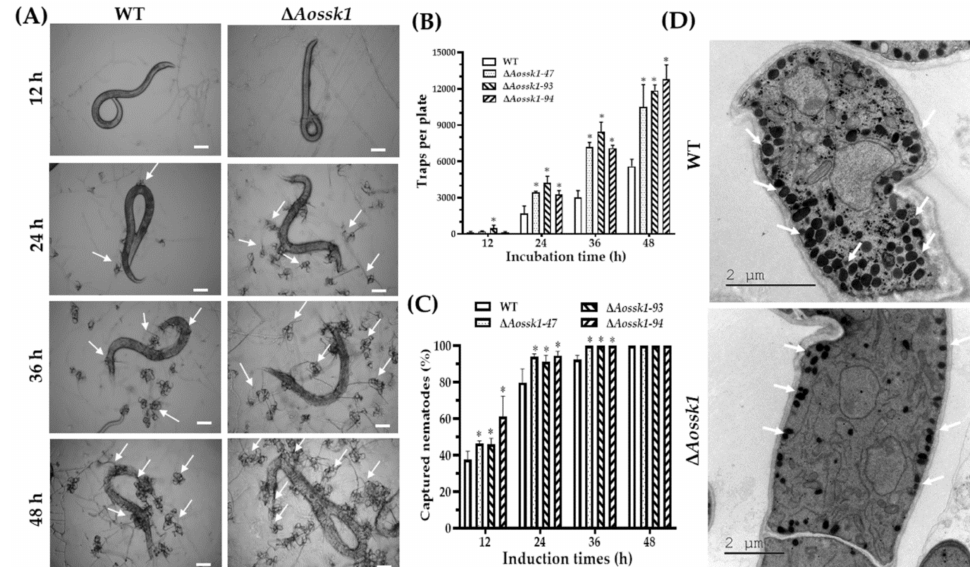
Figure 6. Comparison of trap formation, nematicidal activity, and electron-dense bodies between WT and ∆ Aossk1 mutant strains. ( A ) Trap formation and nematode predation at different time points. White arrows: traps. Bar = 50 µ m. ( B ) Comparison of traps produced by WT and ∆ Aossk1 mutant strains at 12, 24, 36, and 48 h. ( C ) Comparison of nematodes captured by WT and ∆ Aossk1 mutant strains at 12, 24, 36, and 48 h. An asterisk ( B , C ) indicates a significant difference between the ∆ Aossk1 mutant strain and the WT strain (Tukey’s HSD, p < 0.05). ( D ) Observation of electron-dense bodies in trap cells of WT and ∆ Aossk1 mutant strains by transmission electron microscopy. White arrows: ED